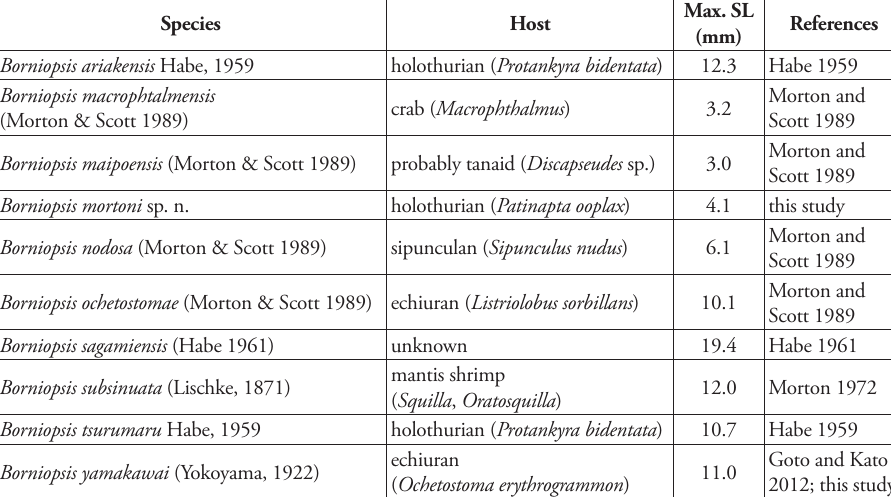
Table 2. Borniopsis , its host and maximum size (shell length).